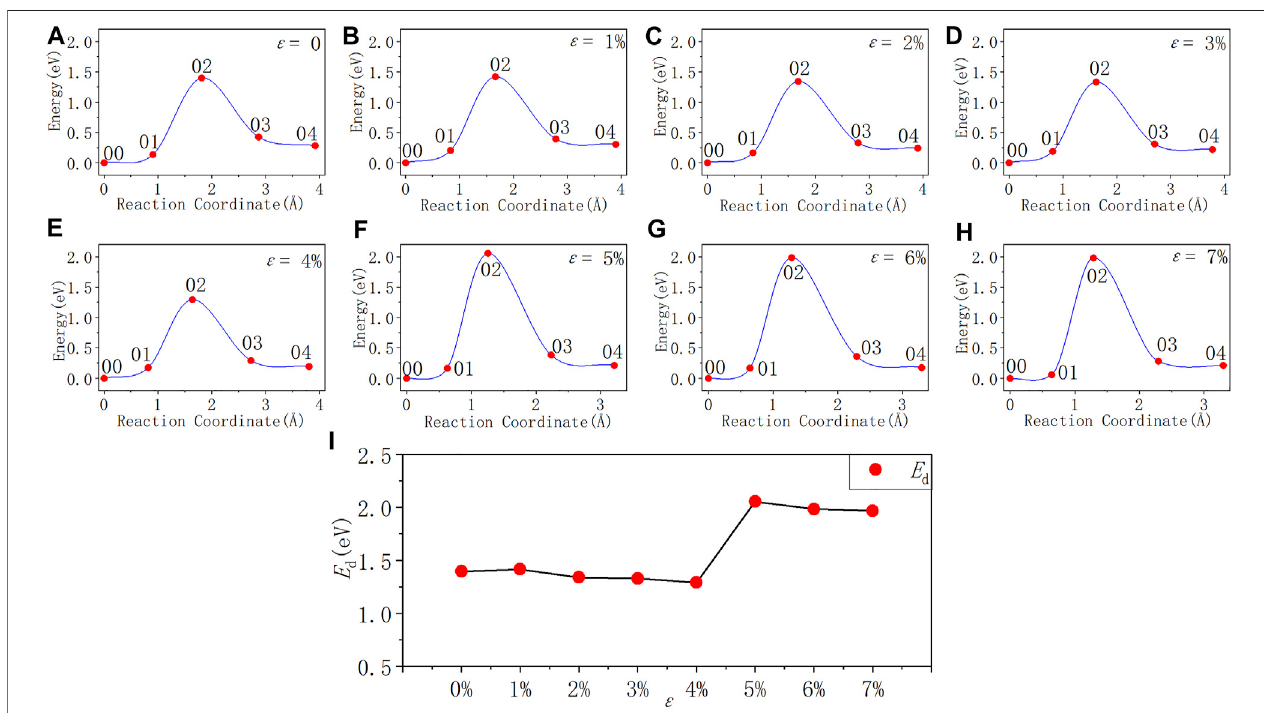
FIGURE 6 | Reaction energy curves and activation energy pro fi le curve ofthe P b defect depassivation; (A – H) exhibit depassivation reaction energy curves under a tensile strain range of 0%~7%, and (I) exhibits the activation energy pro fi le curve.